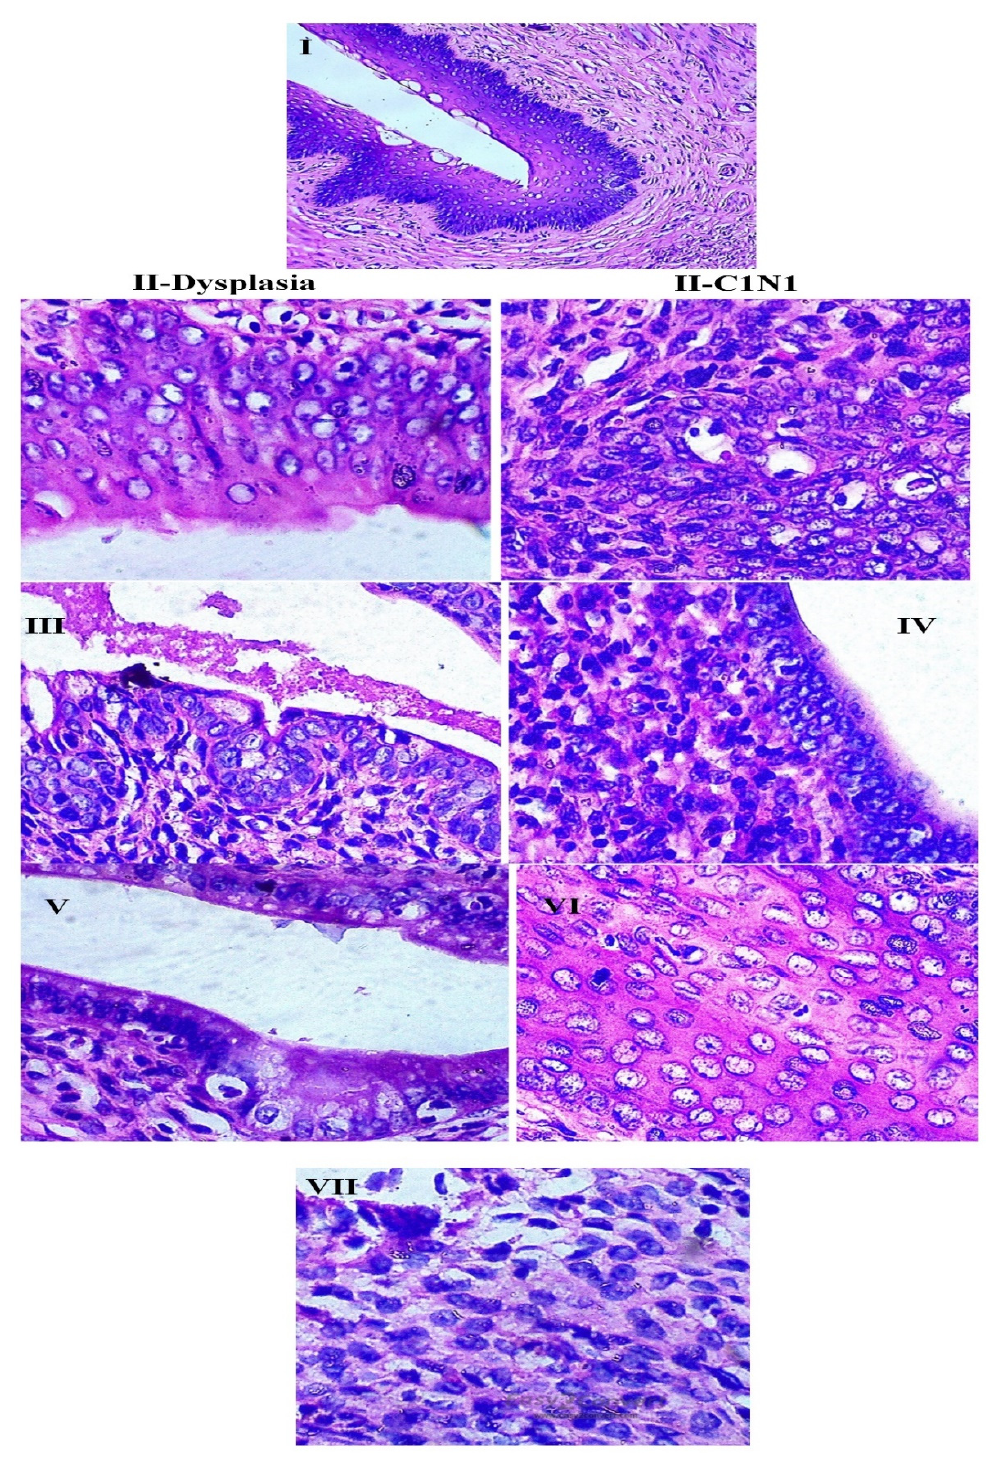
Figure 7. Histopathology of cervical tissues for control and drug(s) treated SD animals. SD rats from each group was randomly selected. I – VII : Experimental groups; BaP: Benzo (a) pyrene; DoE: Dimer of Epicatechin; CIN1: Cervical intraepithelial neoplasia 1; IED-N: Intraepithelial cells disturbance-neoplasia; SEJ: squamous columnar epithelial junction.